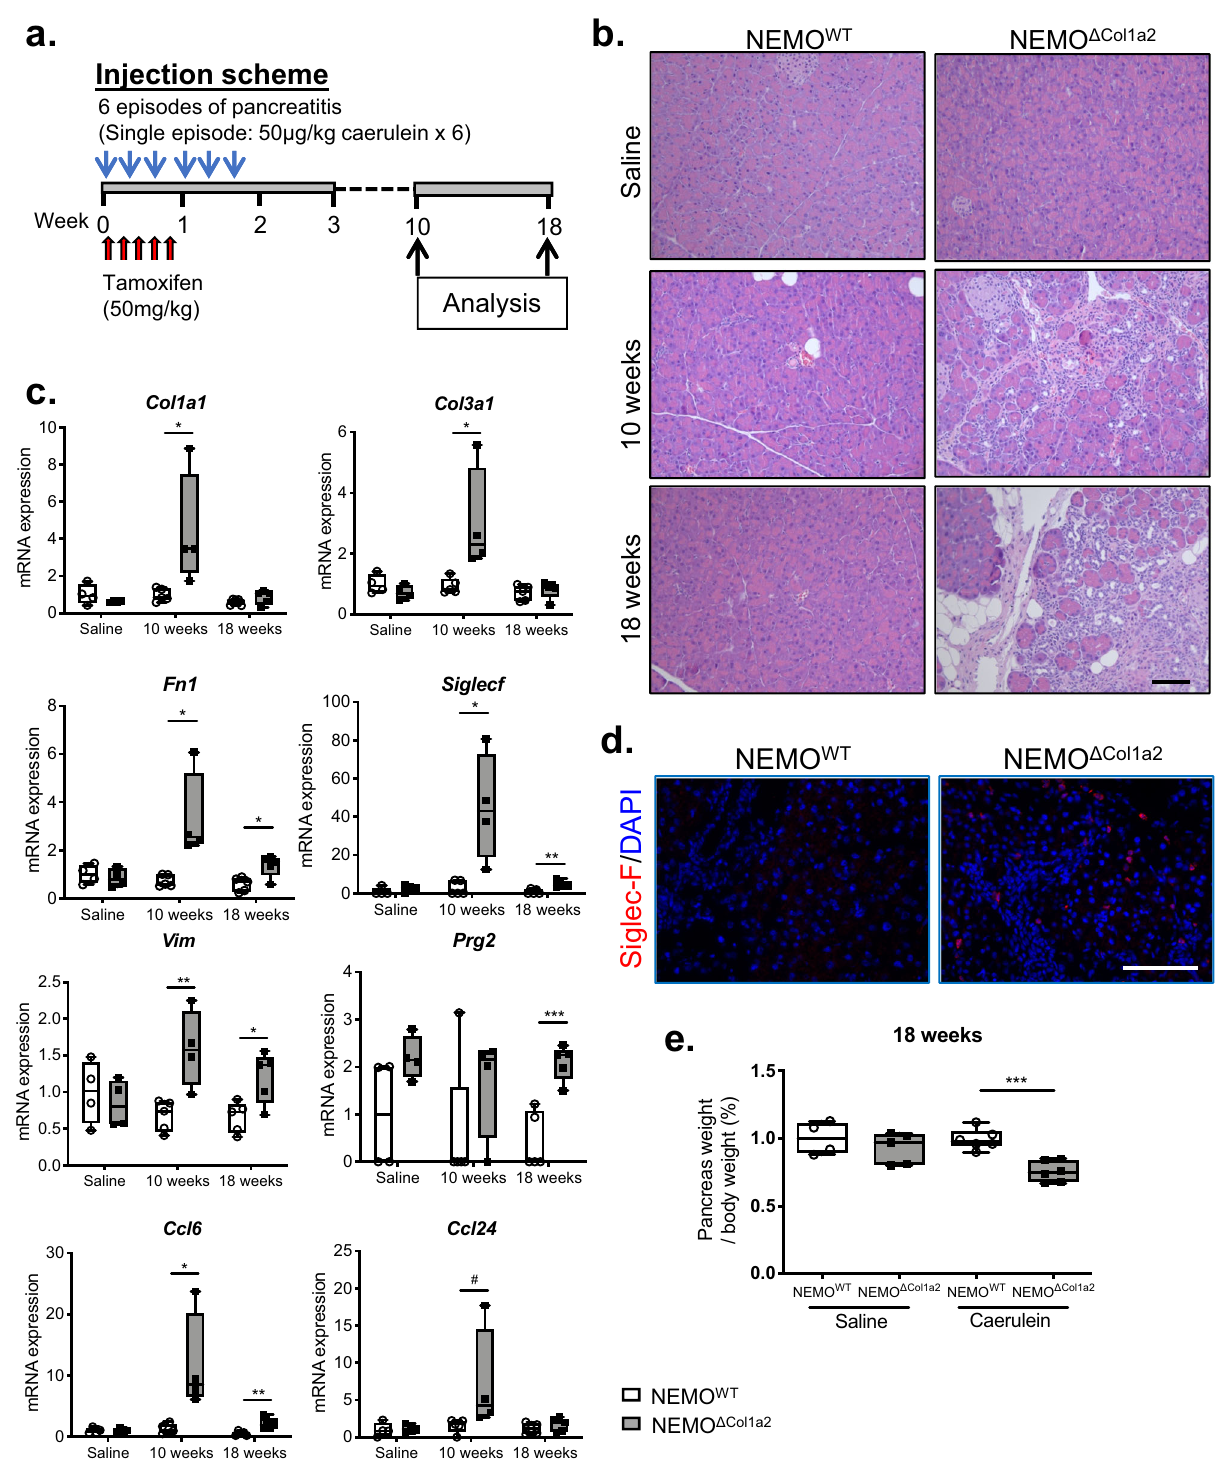
Fig. 7 NEMO Δ Col1a2 mice demonstrate an impaired recovery after pancreatitis. a NEMO Δ Col1a2 and NEMO WT mice injected with tamoxifen and caerulein were studied over 18 weeks. b Pancreatic histology showing a complete recovery in the NEMO WT group, while the NEMO Δ Col1a2 pancreata still displayed in fl ammation, fi brosis and structures of metaplastic ductal lesions. Scale bar: 100 µ m. c Expression of pro- fi brogenic genes and eosinophil markers analyzed by qPCR ( n ≥ 4). d Siglec-F staining showing the presence of eosinophils in the pancreata of NEMO Δ Col1a2 mice (18 weeks). Scale bar: 100 μ m. e Ratio of pancreatic weight to the body weight ( n ≥ 4). Whiskers: Min to Max. T -test (two-tailed): * p < 0.05; ** p < 0.01; *** p < 0.001. Mann – Whitney (two-tailed): # p < 0.05. All n numbers represent biological